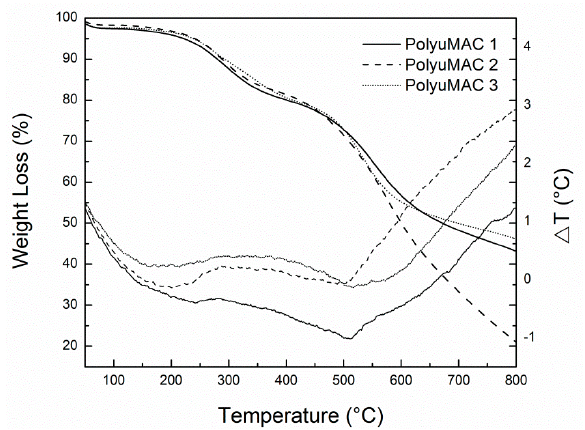
Figure 3. Thermogravimetric analysis (TGA) signal (left axis) and simultaneous differential thermal analysis (STDA) signal (right axis) of the polyamide samples.